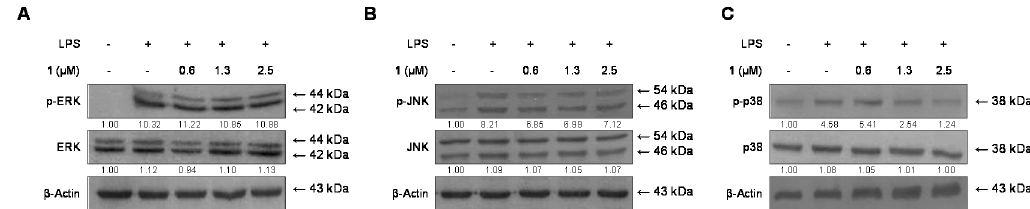
Figure 6. Effects of cudratricusxanthone A ( 1 ) on ERK, JNK, and p38 MAPK phosphorylation and protein expression. Cells were pretreated for 3 h with the indicated concentrations of cudratricusxanthone A ( 1 ) and stimulated for 1 h with LPS (1 µg/mL). The LPS treatment was performed in the presence of compound. The levels of ( A ) phosphorylated ERK (p-ERK); ( B ) phosphorylated JNK (p-JNK); and ( C ) phosphorylated p38 MAPK (p-p38 MAPK) were determined by western blotting. Representative blots from three independent experiments with similar results and densitometric evaluations are shown. Band intensity was quantified by densitometry and normalized to β -actin, and the values are presented at the bottom of each band. “+” is treated, “ − “ is not treated.